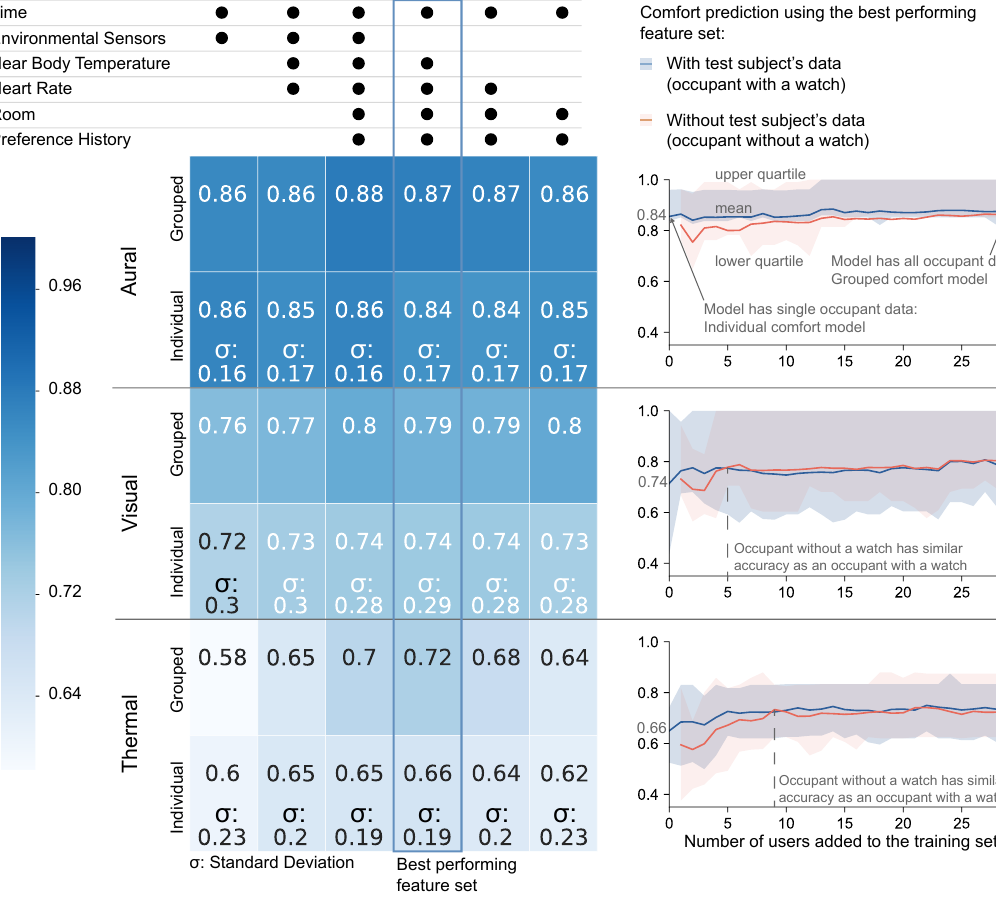
Figure 8. Left : Comparison of prediction F1-micro-score between grouped and individual comfort models using data from different feature sets. The feature set that excluded environmental sensor data for the thermal model had the highest F1-score, while minimal differences in F1-score were noted between feature sets of the visual and aural models. Right : The accuracy in predicting the comfort of an individual as further participants are added to the training set. The blue line includes the test participants training set in the training data, and the orange line excludes the test the participants training data meaning that it depends on crowdsourced feedback from other